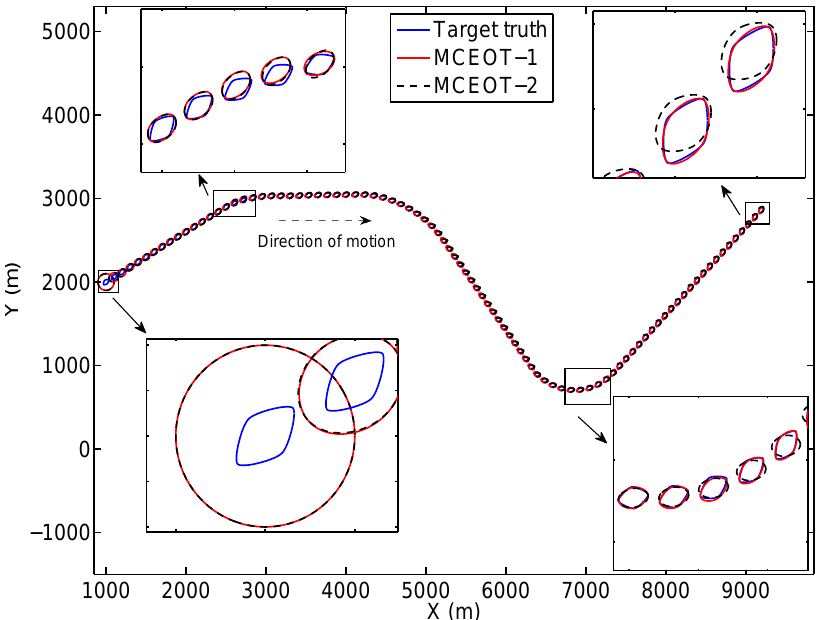
Figure 4. Trajectory of the complex extended object in scenario B (the blue solid line is for the true object, the red solid line and black dash line are for MCEOT-1 and MCEOT-2,